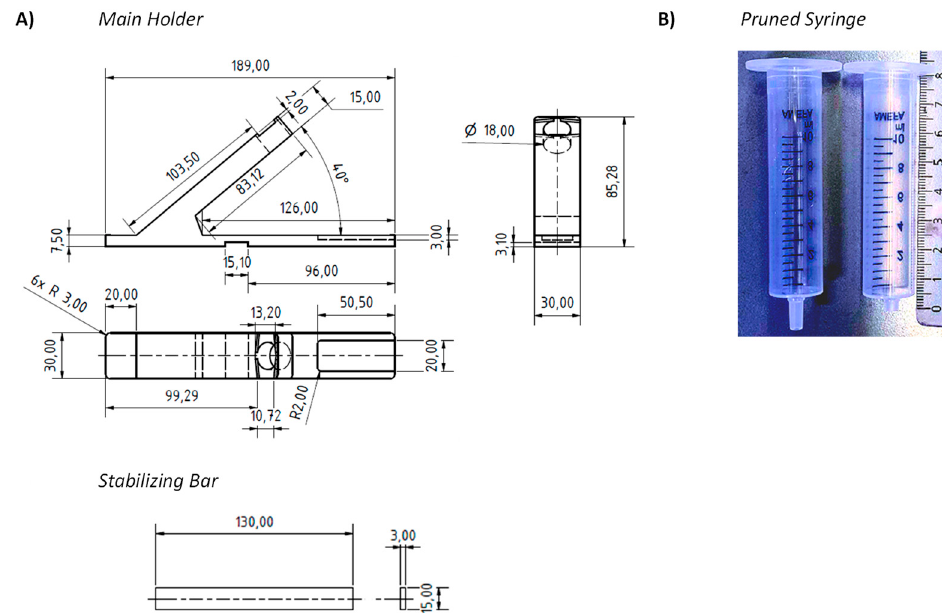
Figure 2. Components of the device. ( A ) Technical drawings showing the dimensions (in mm) of the main holder, the stabilizing bar of the holder, and ( B ) photograph of an unmodified 10 mL syringe next to a syringe used as pooling and extraction container that had its LUER fit pruned to reduce void volume. The length ruler next to the pruned syringe shows the length in cm.